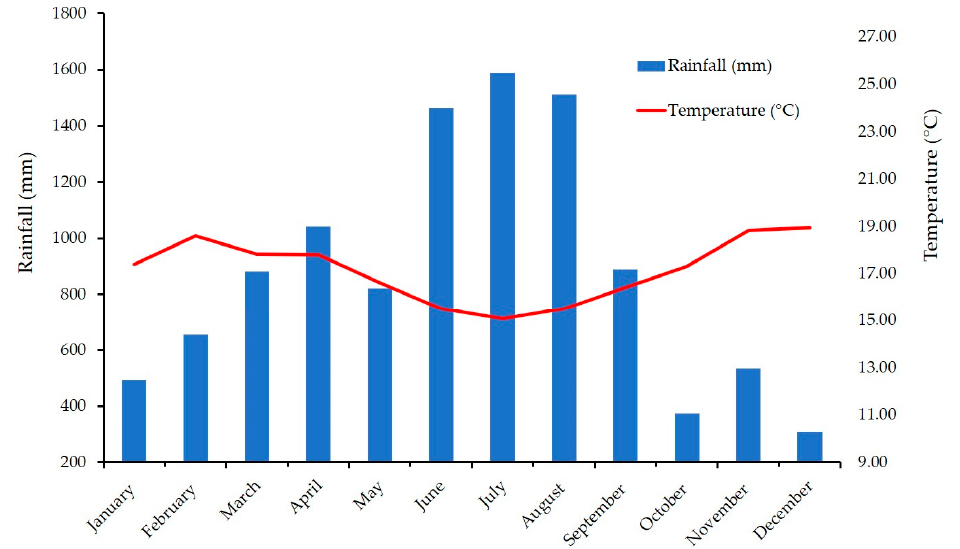
Figure 2. Rainfall and temperature distribution in the study area.